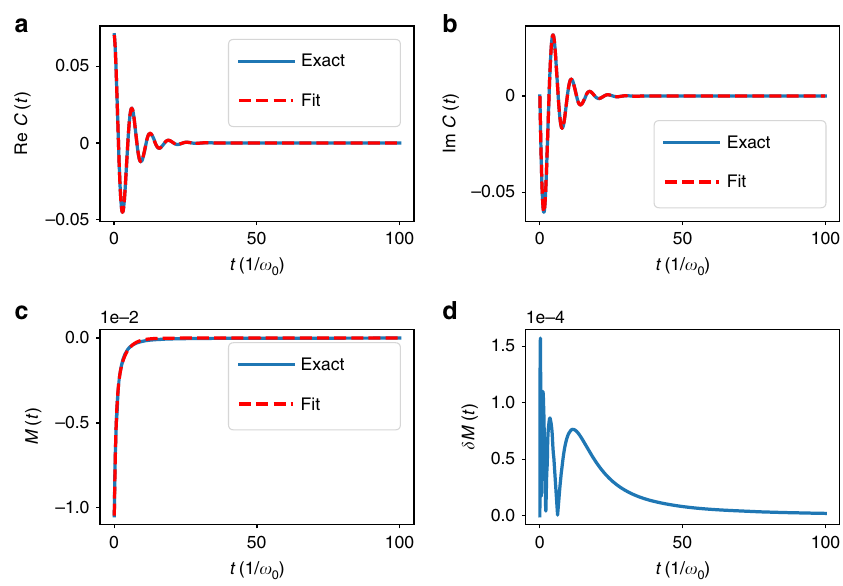
Fig. 1 Free-bath correlation functions. The top two panels show ( a ) real and ( b ) imaginary parts of the correlation function for the under-damped Brownian motion spectral density with λ = 0.4 ω 0 , γ = 0.4 ω 0 , T = 0. The blue solid curves show the evaluation of the formula from Eq. (2) using Eqs. (4) and (8). The red-dashed curves show the reconstruction of the same using Eq. (9) to fi t the Matsubara term, Eq. (8). In the bottom left panel ( c ), we explicitly plot the Matsubara part of the correlation function Eq. (4) alone, and its fi t Eq. (9). The error in the fi t is shown in the bottom right panel ( d ), which is also the same as the error in the real part of the correlation function. The imaginary part is exact, and has no error after the